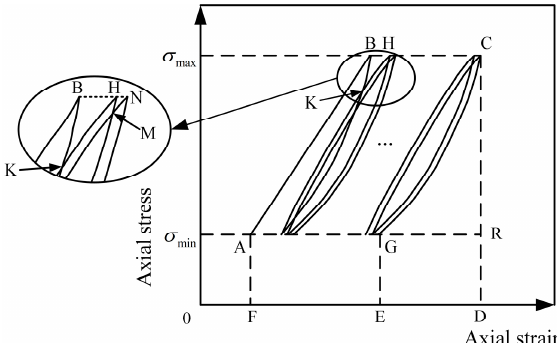
Figure 8. Stress–strain curve of the uniaxial cyclic loading and unloading test.